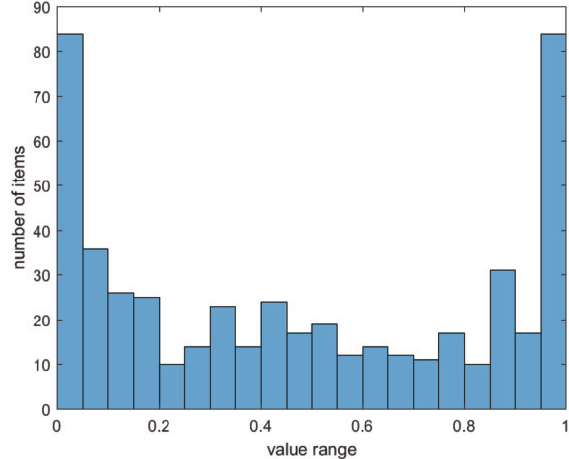
Figure 4. Logistic chaotic sequence distribution